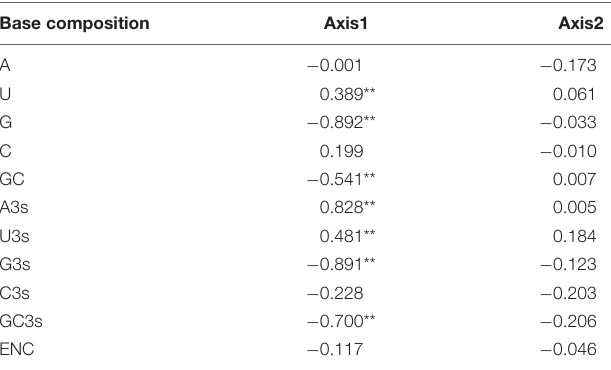
The numbers in each column represent correlation coefficient “r” values, which are calculated in each correlation analysis. “**” means P <